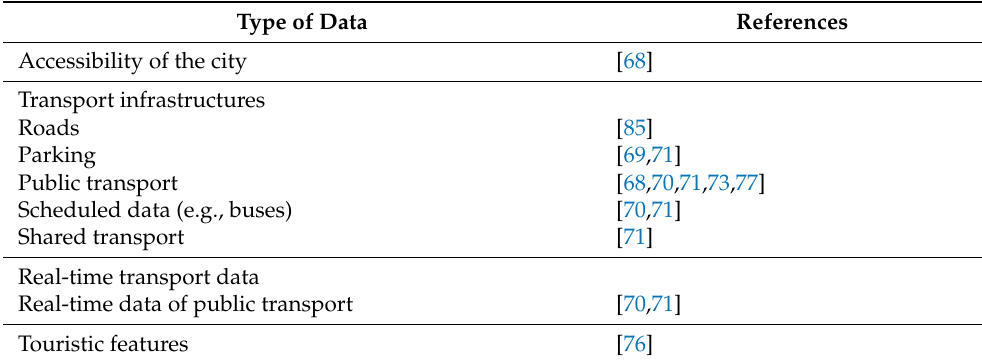
Table 5. Open data from the smart city.